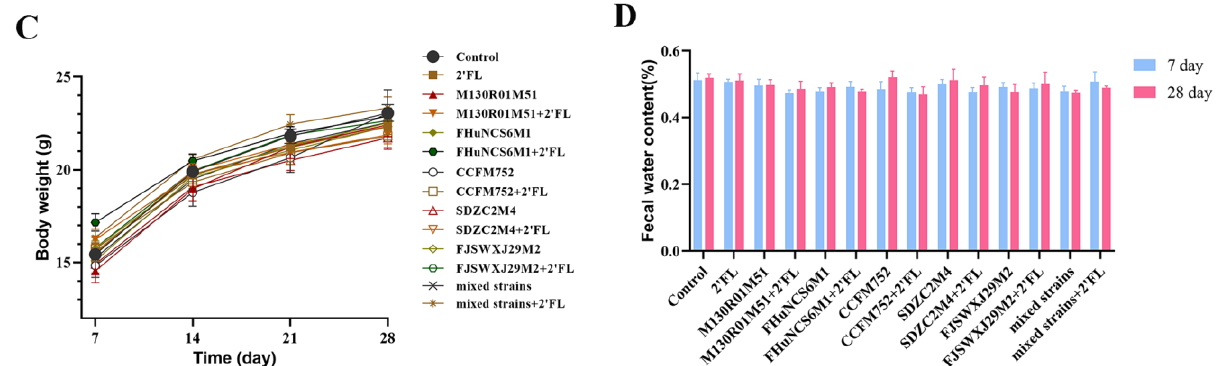
Figure 1. Effects of Bifidobacterium with different utilization of 2 ′ FL on physiological indexes in mice (n=8). ( A ) Food intake, ( B ) water intake, ( C ) body weight, ( D ) fecal water content (%). Statistical differences were calculated by ANOVA followed by Duncan analysis and different letters indicate significant differences between the groups ( p < 0.05).